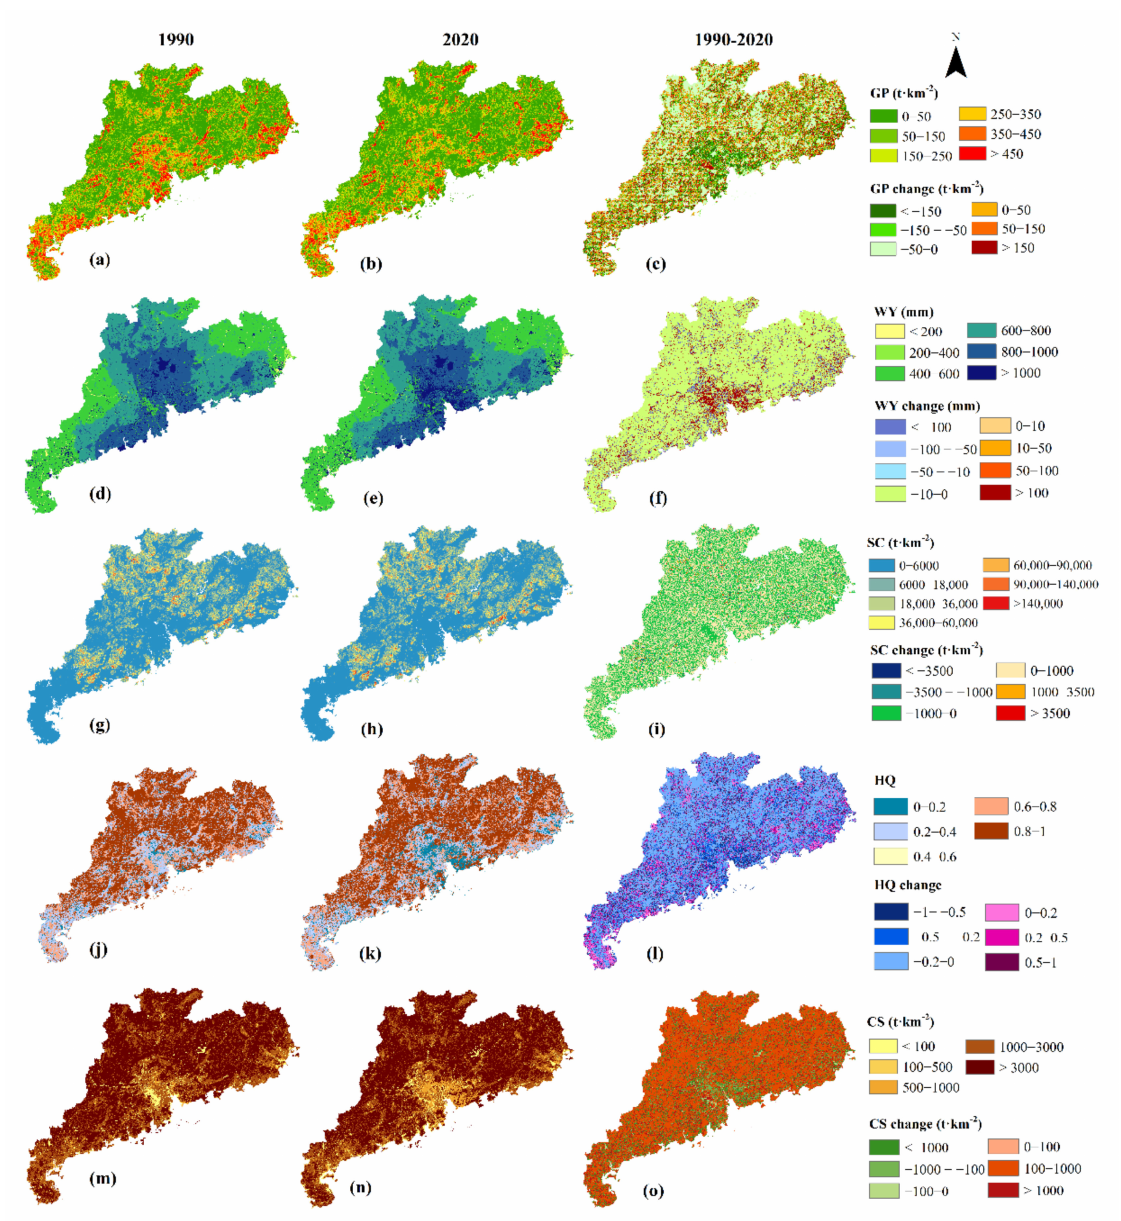
Figure 5. Spatial distribution and changes of the five key ecosystem services in Guangdong